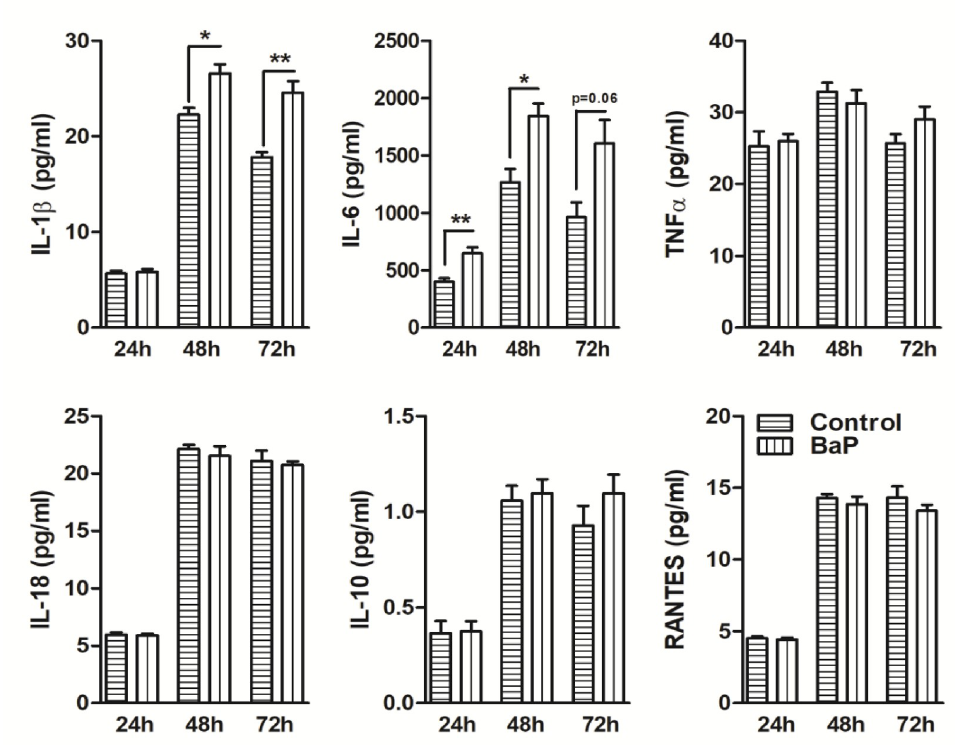
Fig 7. Levels of cytokines and chemokines in BaP-treated SVGA cells. Multiplex ELISA analyses of pro-inflammatory cytokine (IL-1 β , IL-6, TNF α , IL-18), anti-inflammatory cytokine (IL-10), and chemokines (RANTES) were performed in SVG cells (at 24, 48, and 72 h) treated with 1 μ M concentration of BaP (daily treatment). Statistical analyses were carried out by using Student’s t-test (two groups each time point). Results are expressed as means ± S.E.M of n = 3–4 experiments. � P � 0.05 and �� P � 0.01 in comparison with untreated control.